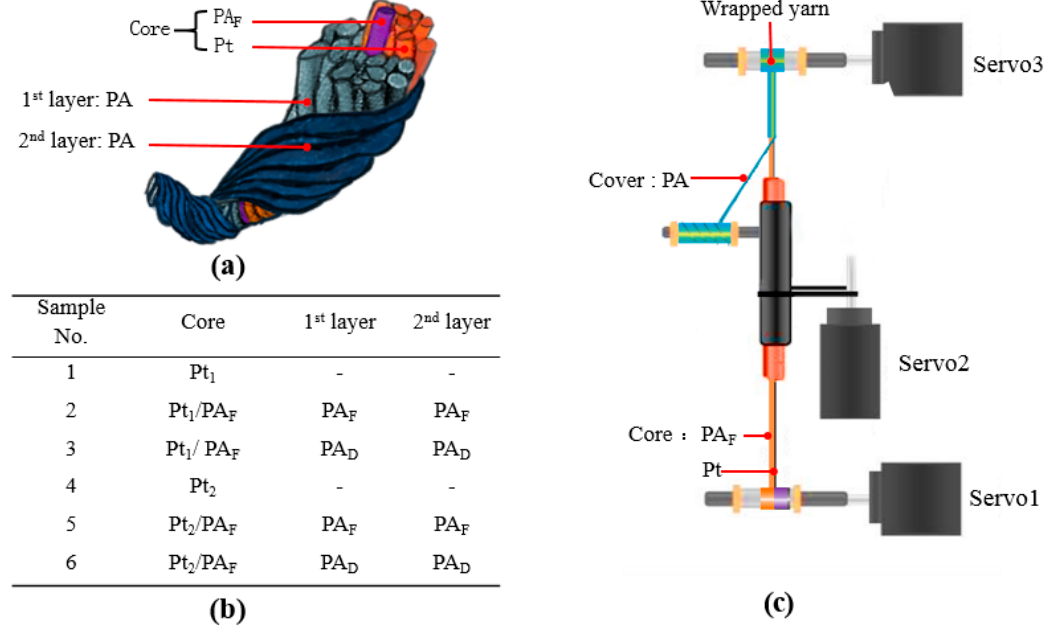
Figure 1. Pt / PA 66 wrapped yarns. ( a , b ) Structure and types of the wrapped yarns; ( c ) Fabrication process. Note: Pt 1 and Pt 2 are the Pt fibers with diameters of 20 µ m and 30 µ m, respectively. PA F means PA-FDY; PA D means PA-DTY.